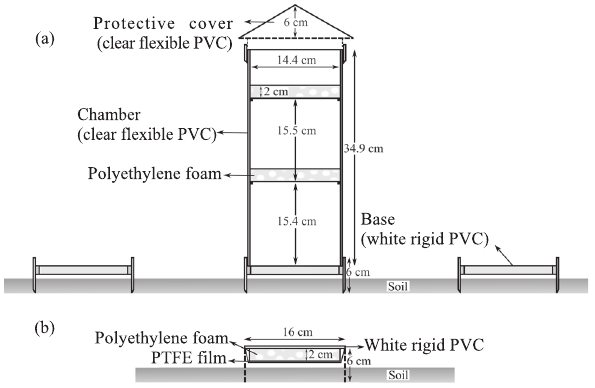
figure 1. A semi-open static collector and its respec- tive pVC bases (a) and an open collector with an absorber wrapped in ptfe film (b) used to quantify nH 3 -n volatilized from urea applied over sugarcane straw. Adapted from Lara Ca- bezas & trivelin (1990) and Alves et al.